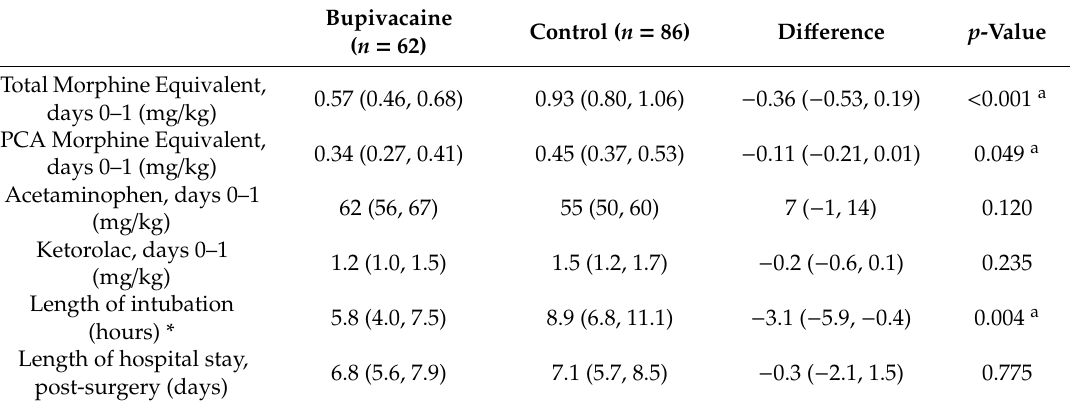
Table 5. Outcome characteristics (unadjusted analysis).